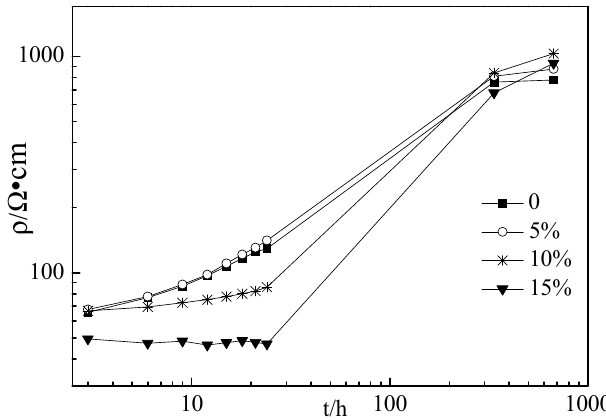
Figure 4. Electrical resistivity of specimens with the w/c ratio of 0.45.